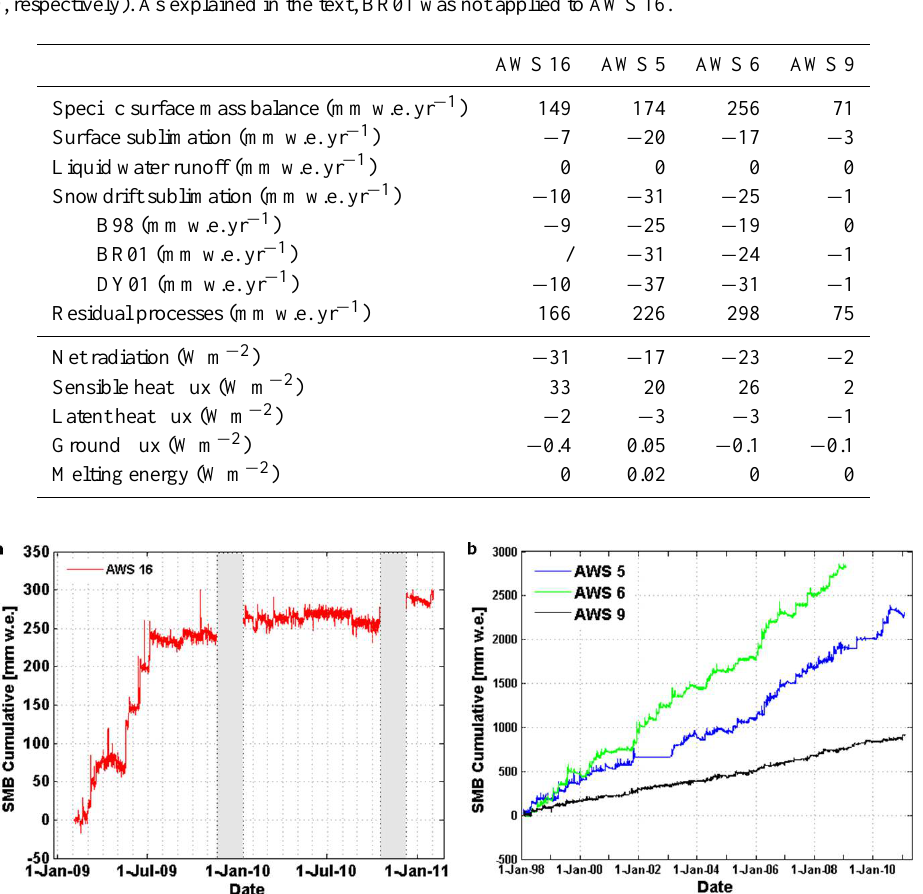
Table 3. Comparison of specific surface mass balance and its components (mm w.e. yr − 1 ), and mean surface energy balance components (Wm − 2 ) at each station. The values at each station are valid for the respective measurement period at this station (2, 13, 11 and 13yr at AWS 16, 5, 6 and 9, respectively). As explained in the text, BR01 was not applied to AWS 16.